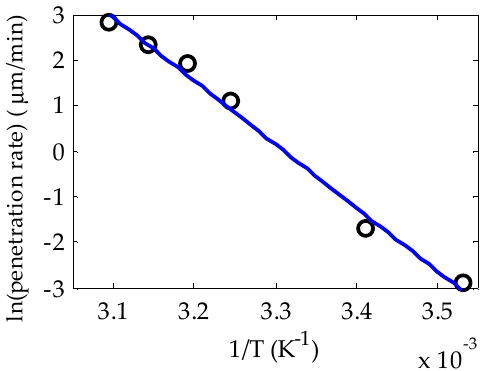
Figure 4. Arrhenius plot for the solution of rhodamine B and methanol penetrating in PMMA POFs. The coefficient of determination of the fitting is 0.9901.